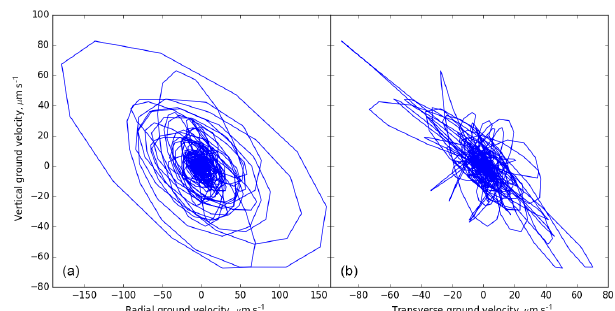
Figure 5. Particle plots of seismic wave arrivals for the calving event of 7 July 2015, split into radial and transverse components.